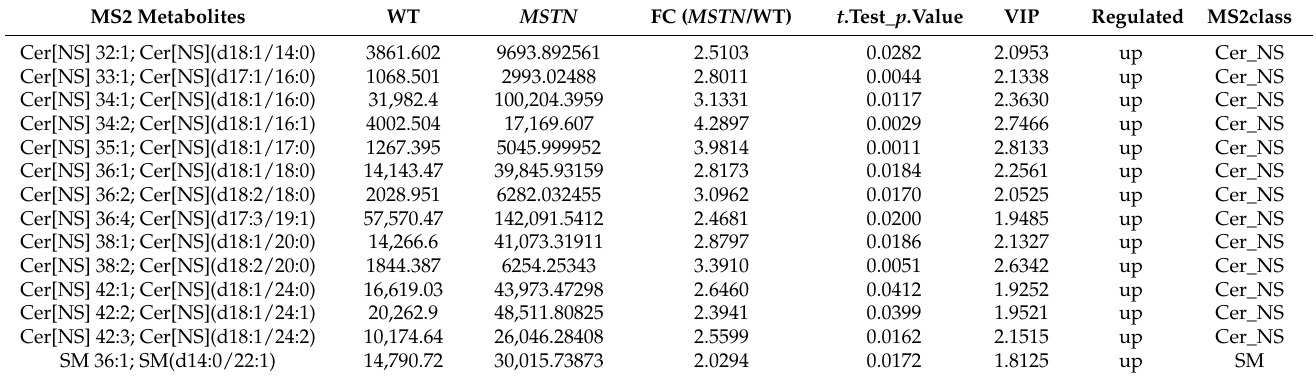
Table 4. Significantly differently expressed sphingolipids in the MSTN +/ − versus the WT